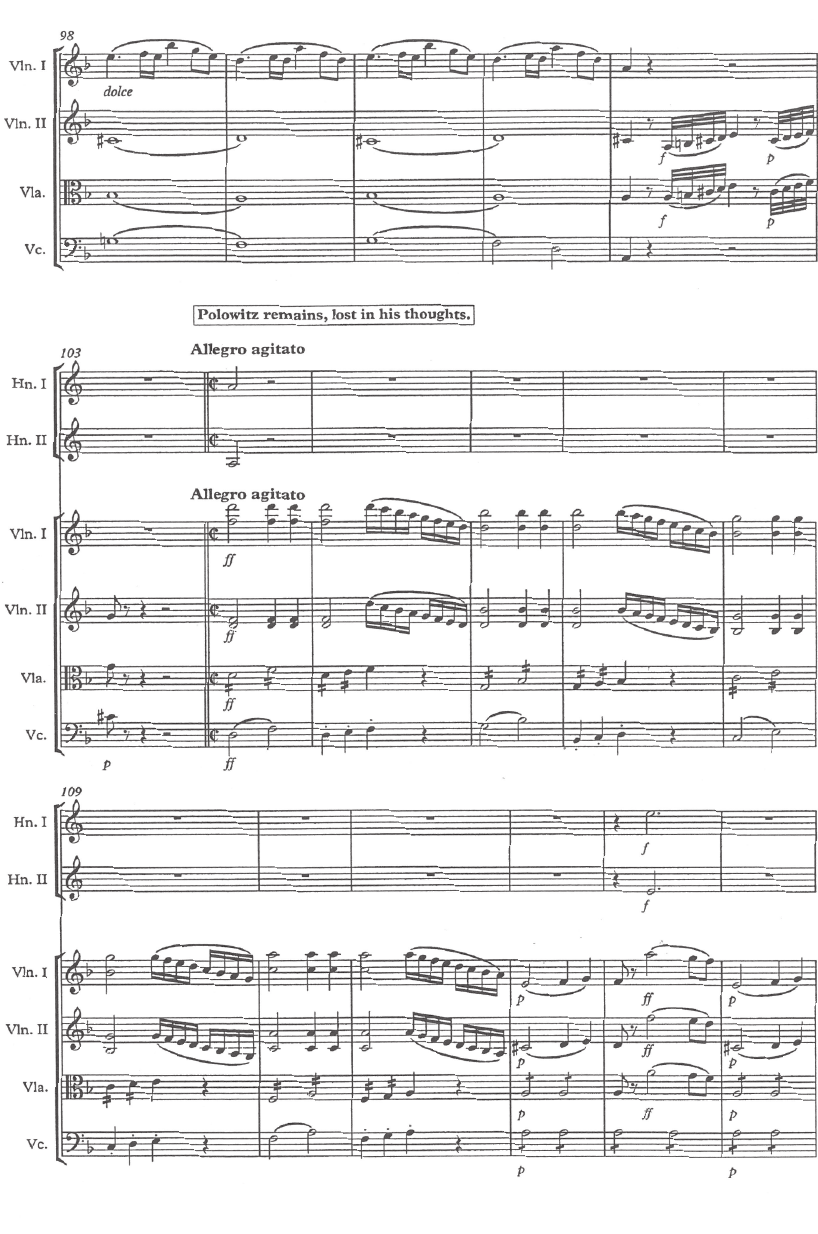
Fig. 4. Piccinni (arr. Tisdall), Roseliska , act 1, no. 6 (Polowitz remains, lost in his